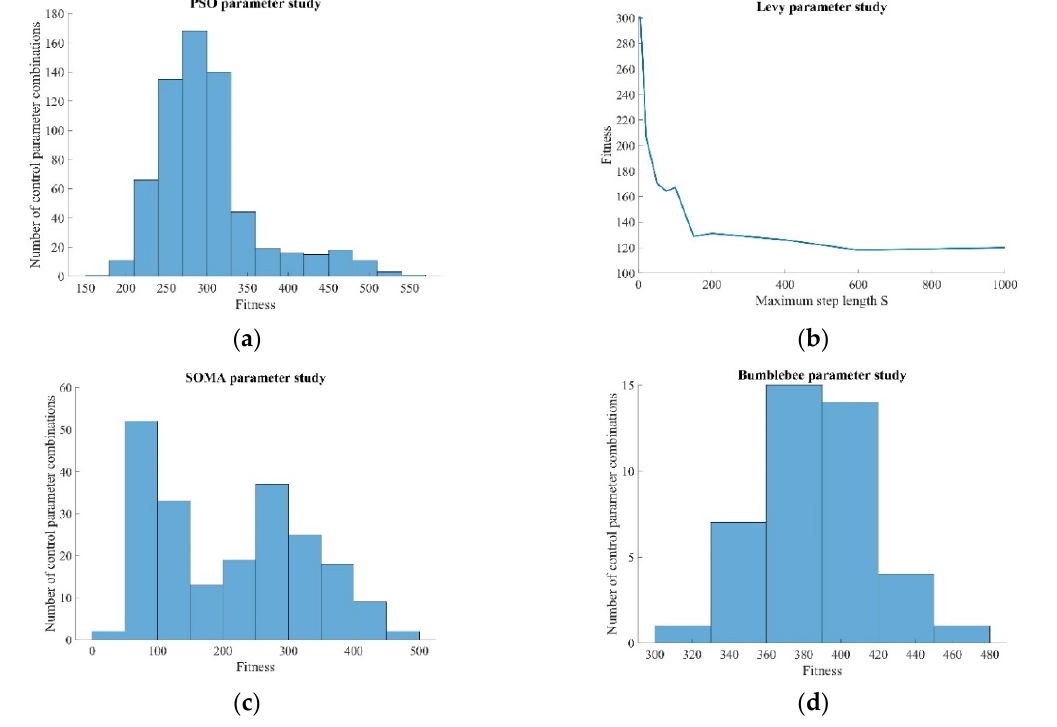
Figure 22. Results from the parameter studies of ( a ) particle swarm optimisation (PSO), ( b ) inertia Levy-flight, ( c ) self-organising migrating algorithm (SOMA), and ( d ) bumblebee search algorithm